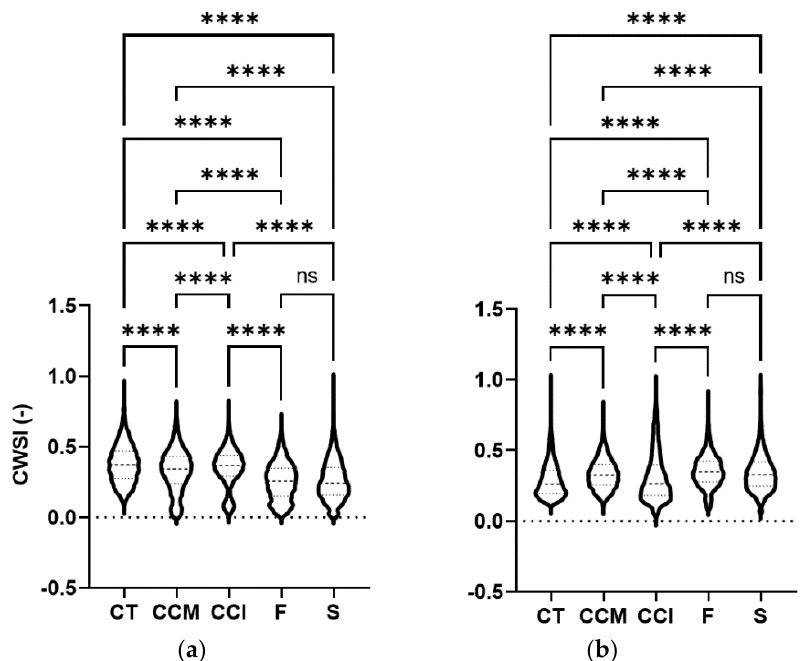
Figure 13. Violin data encoding and pairwise comparison of CWSI values computed for the five soil management treatments for Montevertine ( a ) and San Giusto a Rentennano ( b ). The asterisks indicate statistical significance (P-value ≤ 0.0001 )